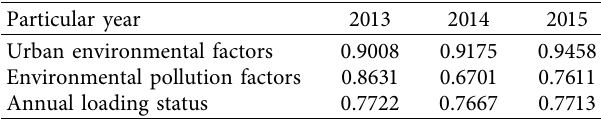
Table 7: Ecocultural bearing status of environmental subsystem of London urban agglomeration